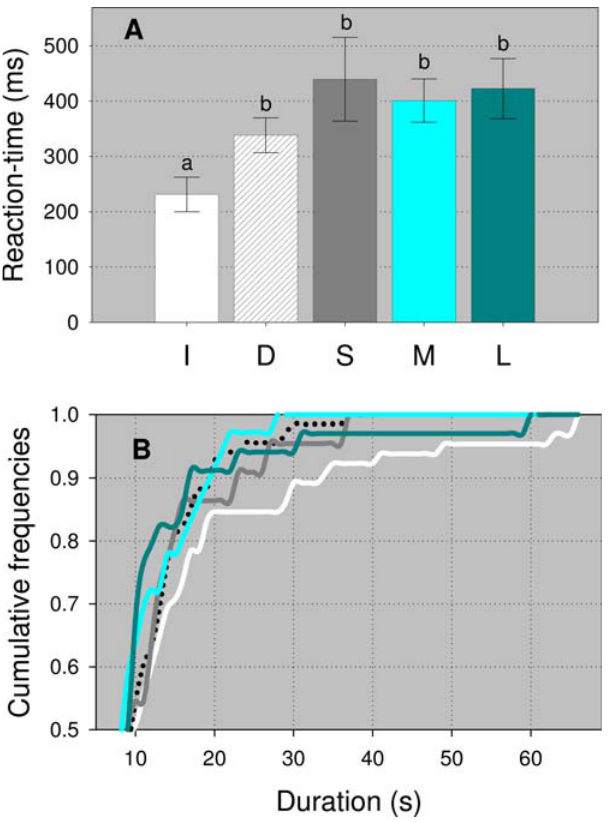
Figure 1. Reaction times and CPE durations. A) Mean ( 6 s.e.m) reaction-time (in ms) of the animals’ proboscis extension responses. B) Cumulative frequencies of CPE durations (in seconds). The data from the different series are shown separately: white, dashed, gray, cyan and dark-cyan bars and lines correspond to the increasing (I, n=63), decreasing (D, n=68), small (S, n=22), medium (M, n=35) and large (L, n=34) series, respectively. In A , different letters indicate statistical differences across series: Kruskal-Wallis test, H=26.66, P , 0.001; Dunn’s multiple comparisons P , 0.001.